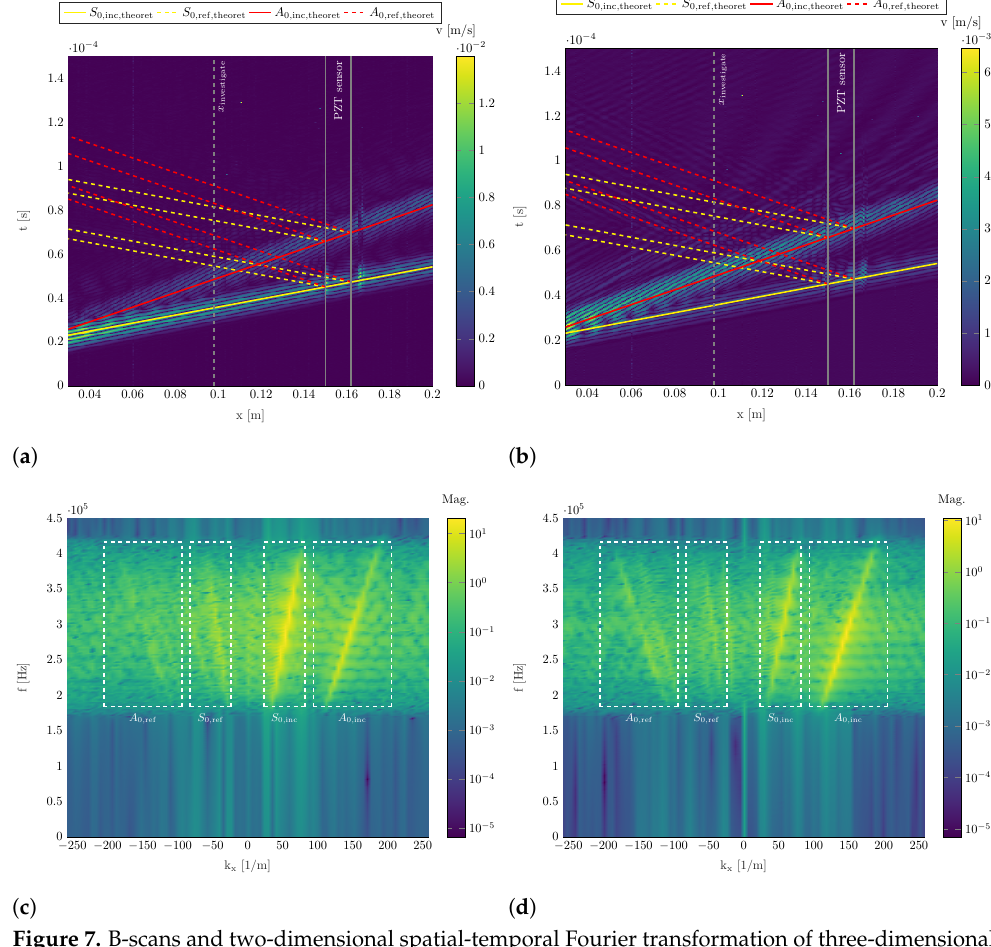
Figure 7. B-scans and two-dimensional spatial-temporal Fourier transformation of three-dimensional SLDV data at f c = 300kHz in the 2mm aluminum plate along the measuring path containing the PZT sensor (Figure 2b). ( a ) B-Scan (In-plane component). ( b ) B-Scan (Out-of-plane component). ( c ) Two- dimensional FFT of in-plane data (Quadrants 1 and 4). ( d ) Two-dimensional FFT of out-of-plane data (Quadrants 1 and